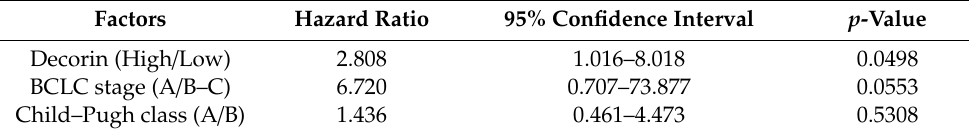
Table 3. Multivariate Cox regression analysis for overall